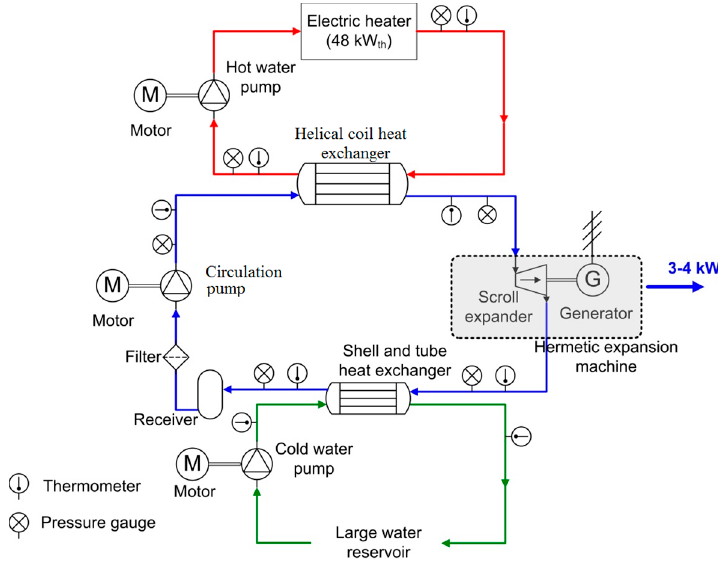
Figure 2. Layout of the experimental ORC test facility (laboratory installation) [2,3,15].